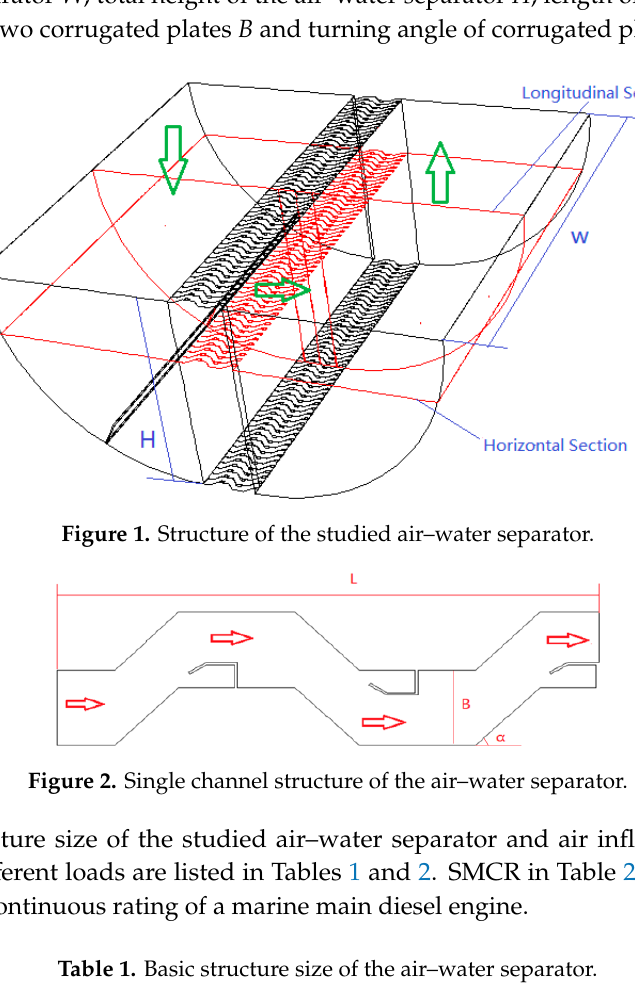
Table 1. Basic structure size of the air–water separator.